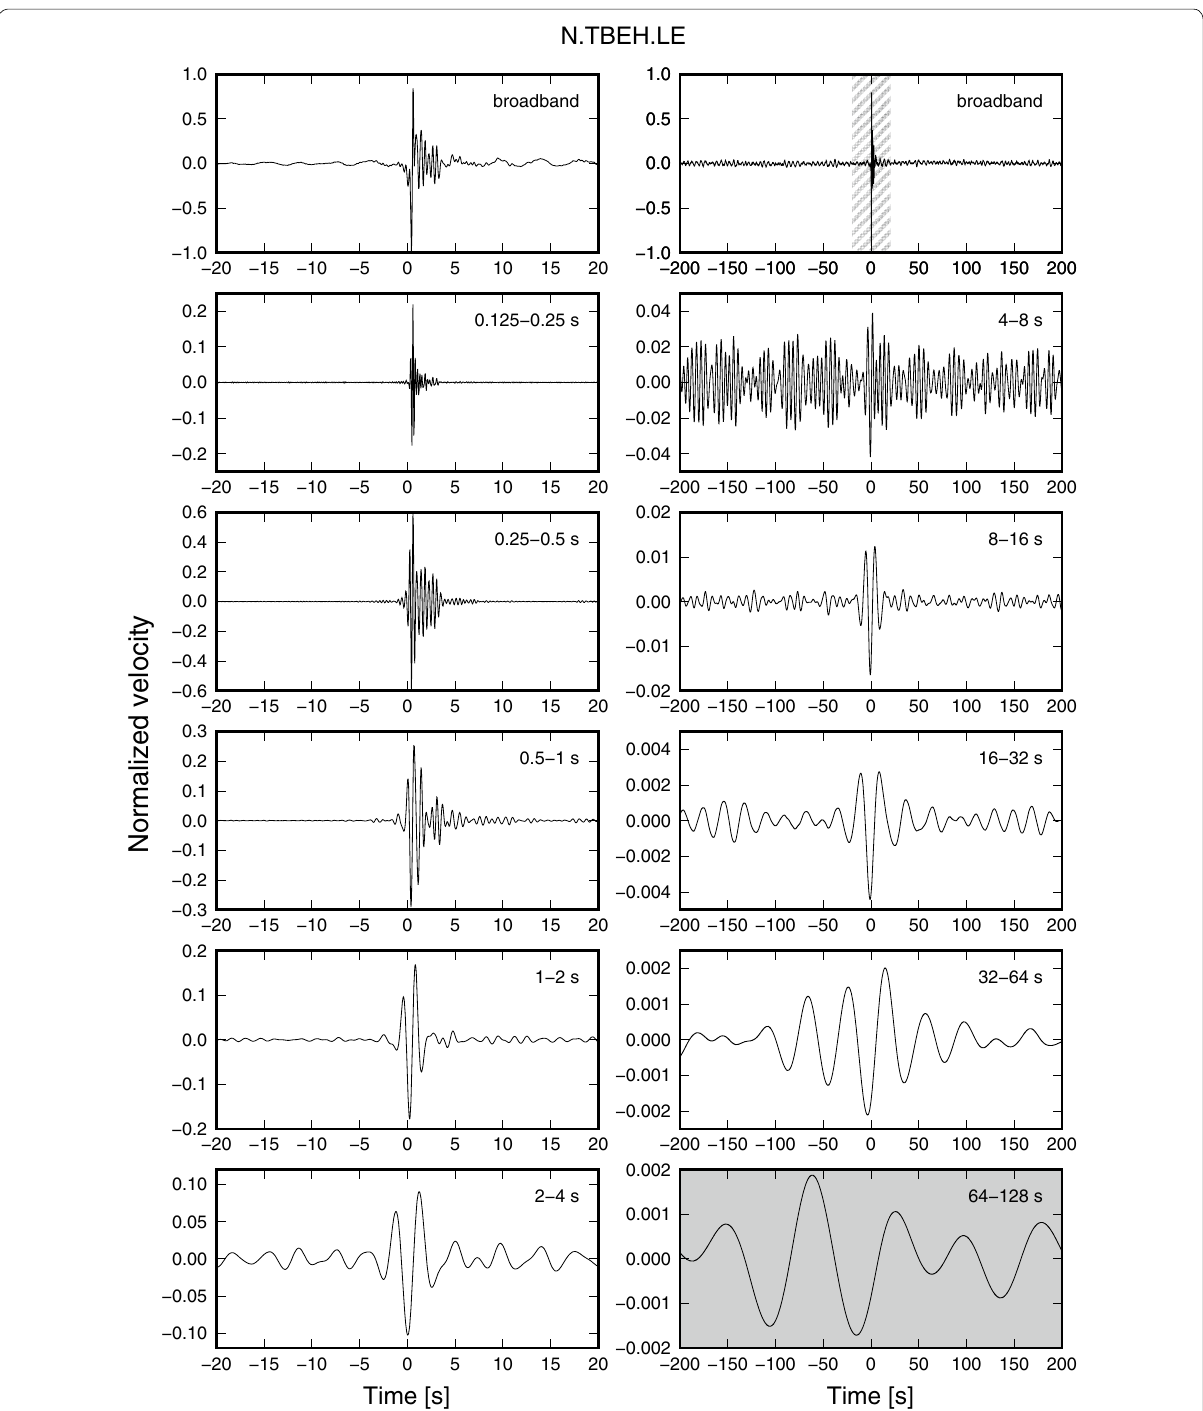
Fig. 3 Example of stacked tiltmeter records for the east–west component at station TBEH. The vertical axis shows the velocity waveforms that were converted from the acceleration signal (see text), which were normalized by the observed long-period components. The top two panels show the same stacked broadband waveform (unfiltered) over 40-s (left) and 400-s (right) time windows. Namely, the area filled with diagonal lines in the top right panel corresponds to the top left panel. The lower ten panels show the bandpass filtered waveforms, with the frequency band of each bandpass filter indicated at top right in each panel. All the waveforms are normalized by the maximum amplitude of the broadband stacked waveform. Microseismic noise has peaks in the 4–8 s and 8–16 s frequency bands. The gray background indicates that noise is dominant in